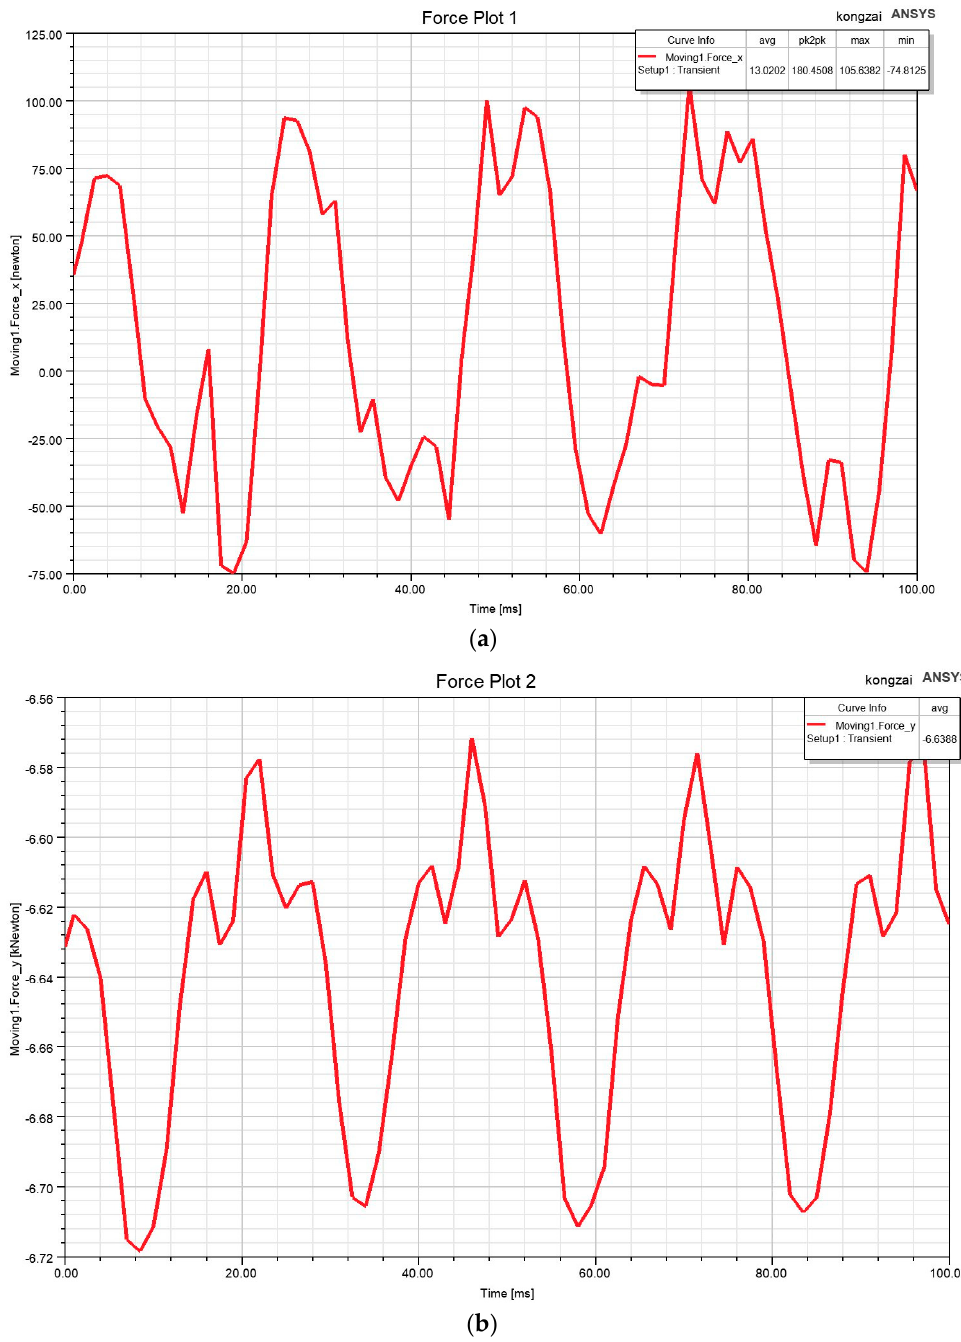
Figure 8. PMLSM horizontal detent force and normal detent force: ( a ) PMLSM horizontal detent force ( b ) PMLSM normal detent force.